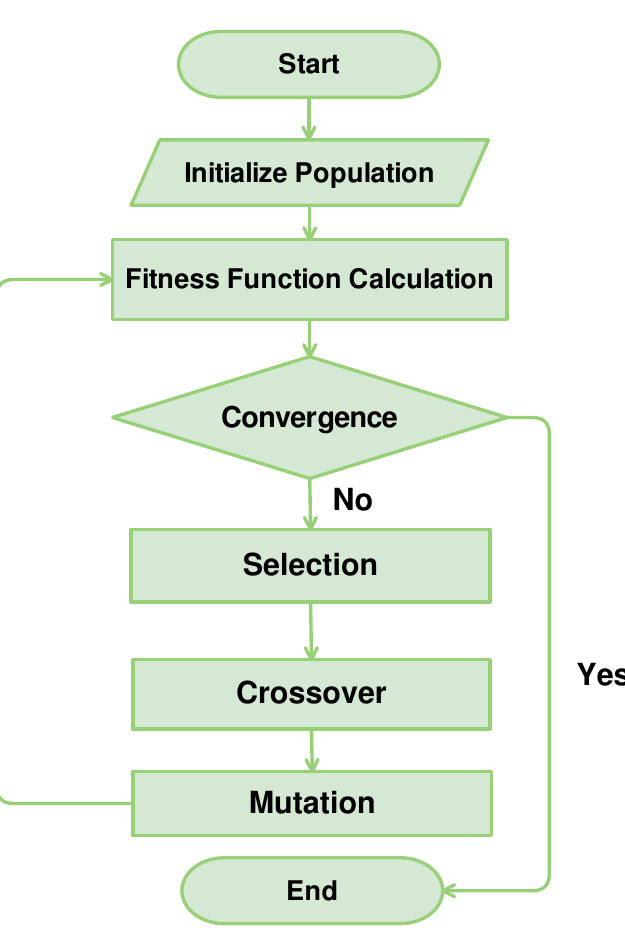
Figure 1. The flowchart of the genetic